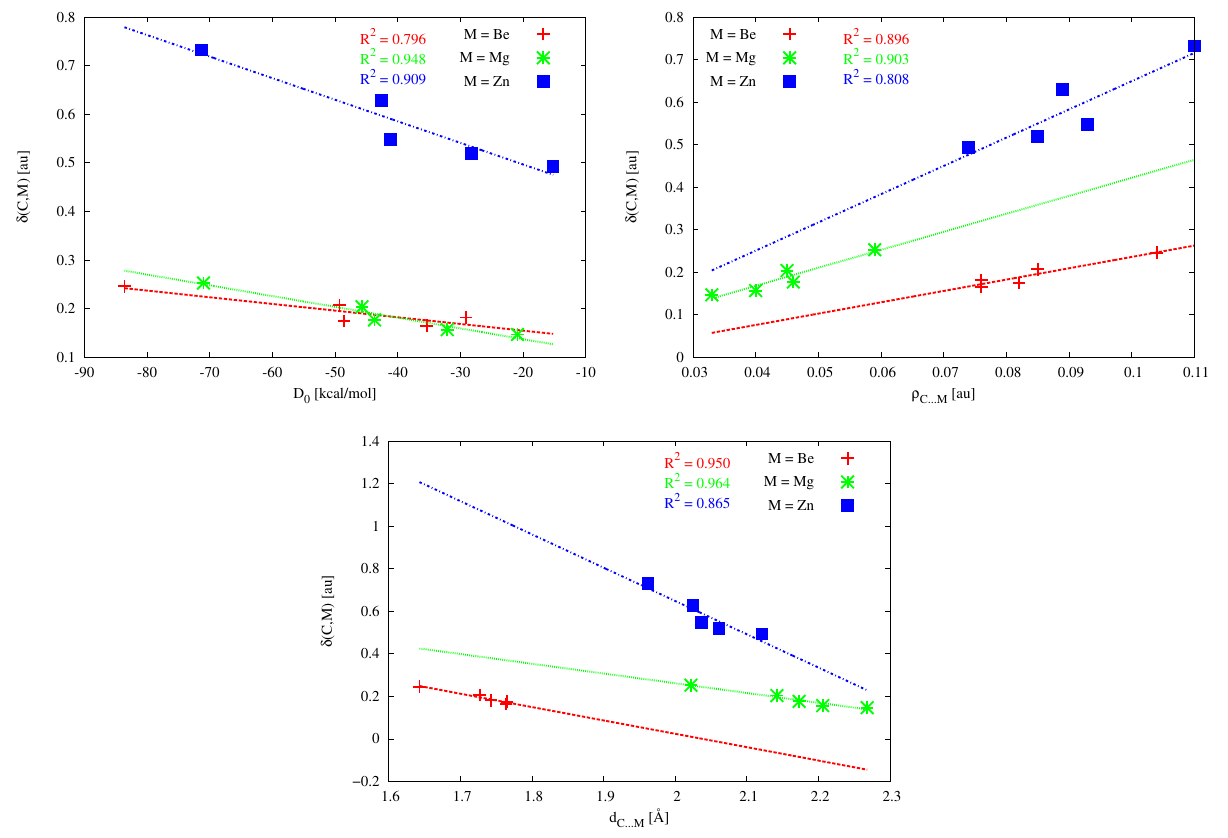
Figure 15. Relationships between the delocalization index of the C and M atomic basins ( δ (C,M)) and the dimer dissociation energy ( D 0 ), the electron density at the bond critical point of the C · · · M interaction ( ρ C ··· M ), or the C · · · M bond distance ( d C ··· M ) determined for the dimers in Table